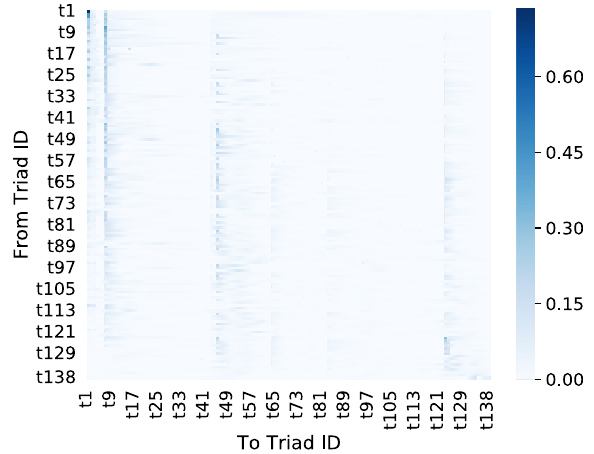
Fig. 2 Transition matrix for all the triads. Average probability transition matrix in the Integrated Crisis Early Warning System (ICEWS) dataset. The average is computed from 101 transition matrices between states that are the 138 possible sparse triads (Supplementary Fig. 2 depicts all these triads). The transition matrix is row-stochastic and its elements fall into (0, 1]. This fi gure shows that there exist only a small number of triad transitions as most elements of this matrix are close to zero. It also depicts that most transitions only happen toward a few of triads. The transition matrix for the top ten most frequent triads is further analyzed in Fig.